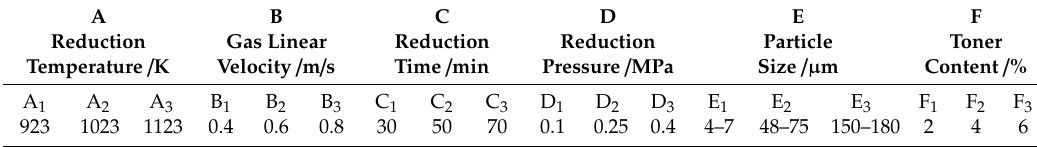
Table 4. Level of each factor.